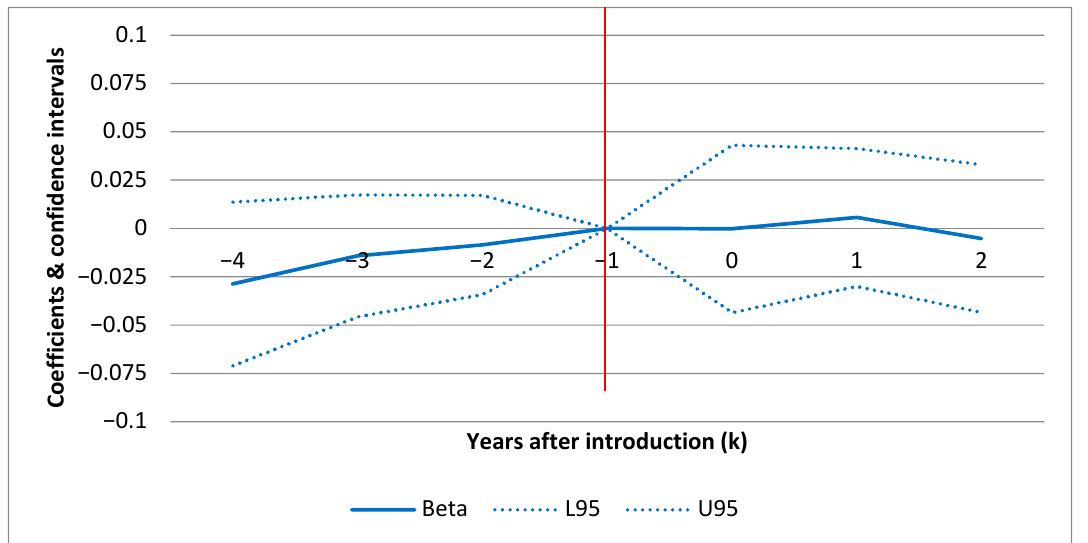
Figure 1. Yearly effects of POCT of HbA1c on admissions, point estimates. Note: dotted lines Figure 1. Yearly e ff ects of POCT of HbA1c on admissions, point estimates. Note: dotted lines represent represent 95% confidence intervals. The model includes year and clinic fixed effects and the full set 95% confidence intervals. The model includes year and clinic fixed e ff ects and the full set of covariates of covariates from Table 6. from Table 6. Int. J. Environ. Res. Public Health 2020 , 17 , x